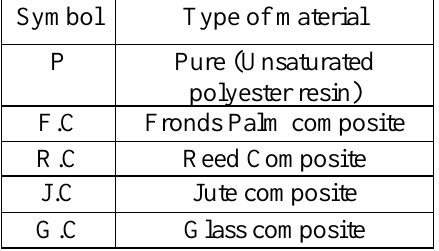
Table 1: The symbols of each type of